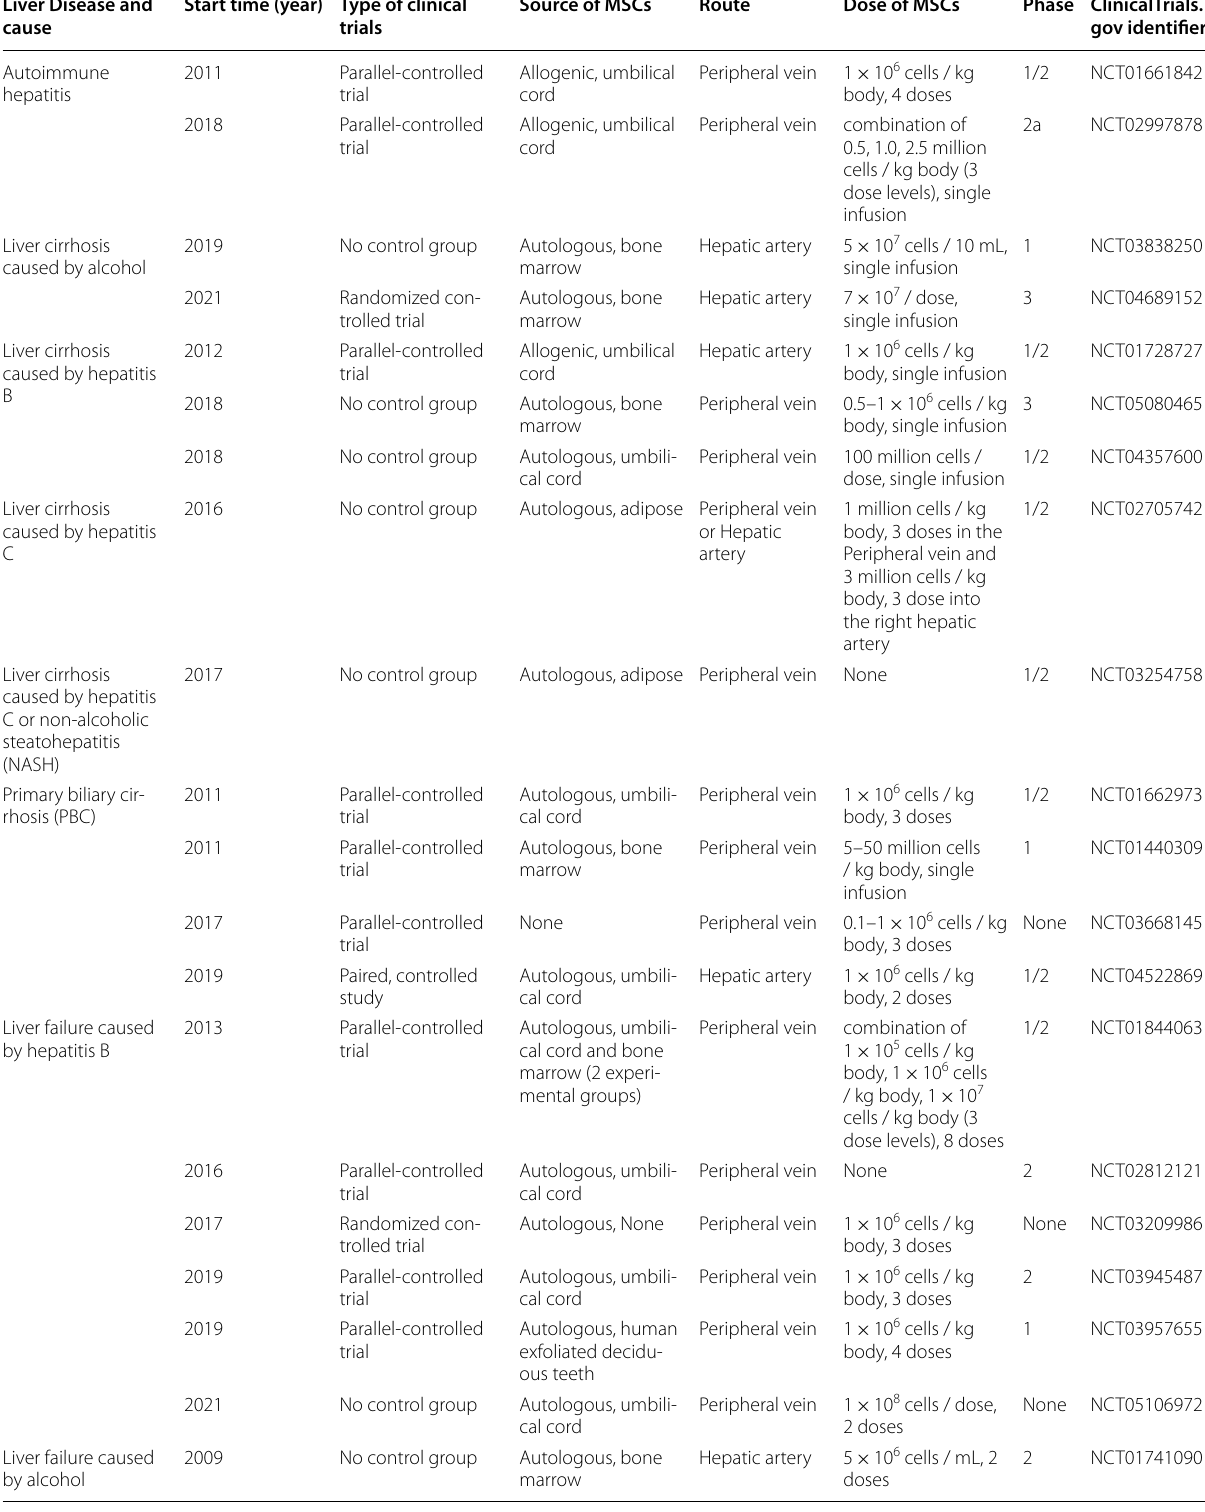
Table 2 Summary of clinical trials on mesenchymal stem cells for liver diseases Liver Disease and